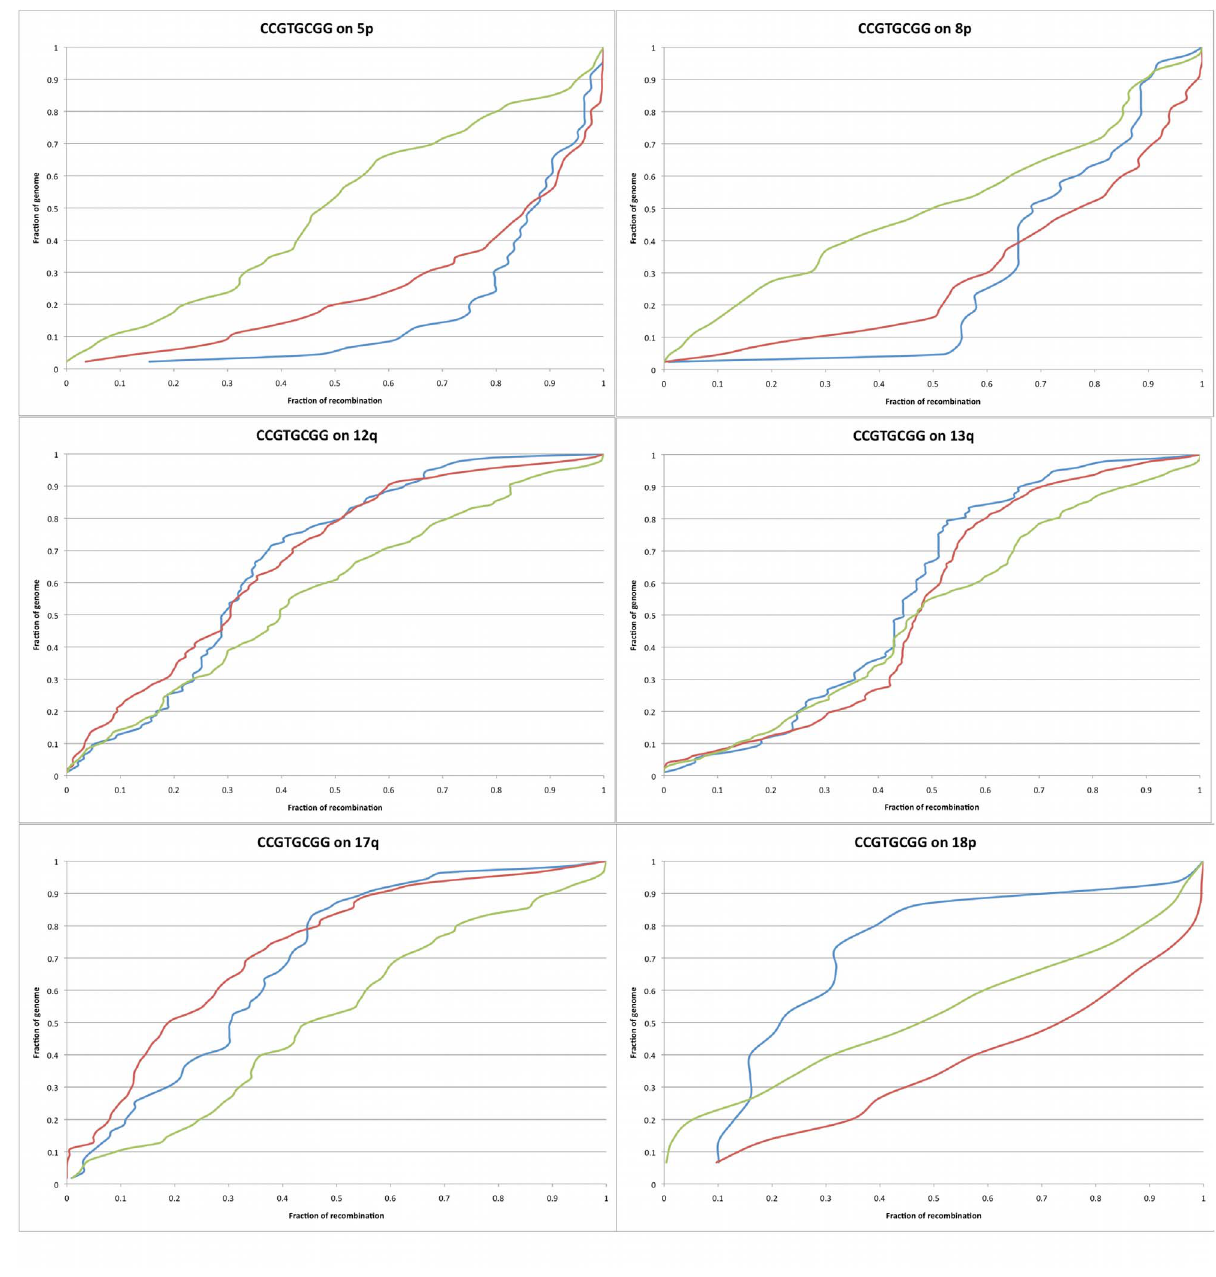
Figure 3. The best fitting motif on male 17q(CCGTGCGG) shown on multiple chromosome arms. Here we demonstrate that while a motif might match well to the deCODE male map on some chromosomes, on others it is terribly matched. The y-axis displays the percentage of the genome. The motif in question is in blue, with the line generated by treating each instance of the motif as though it were a recombination event and dividing the total to each point on the chromosome arm by the total for the entire arm. The female map is in green, while the male map is in red. The x-axis displays the percentage of recombination, the number of recombination events to that point on the arm divided by the total number on the arm. other arm. The single 8-mer, CCGTGCGG, matches best to the chromosome arm in question, and matches some other arms well, but is not a good match to all chromosome arms, and its overall KS score is above 10 (p = 0) (Figure 3). When all pairs of the same motif repeated twice are tested, GGGTGGGT spaced 20 bp apart and GCCGTG spaced 1100bp apart match well to 17q, but they too fail to repeat this matching on all chromosome arms.